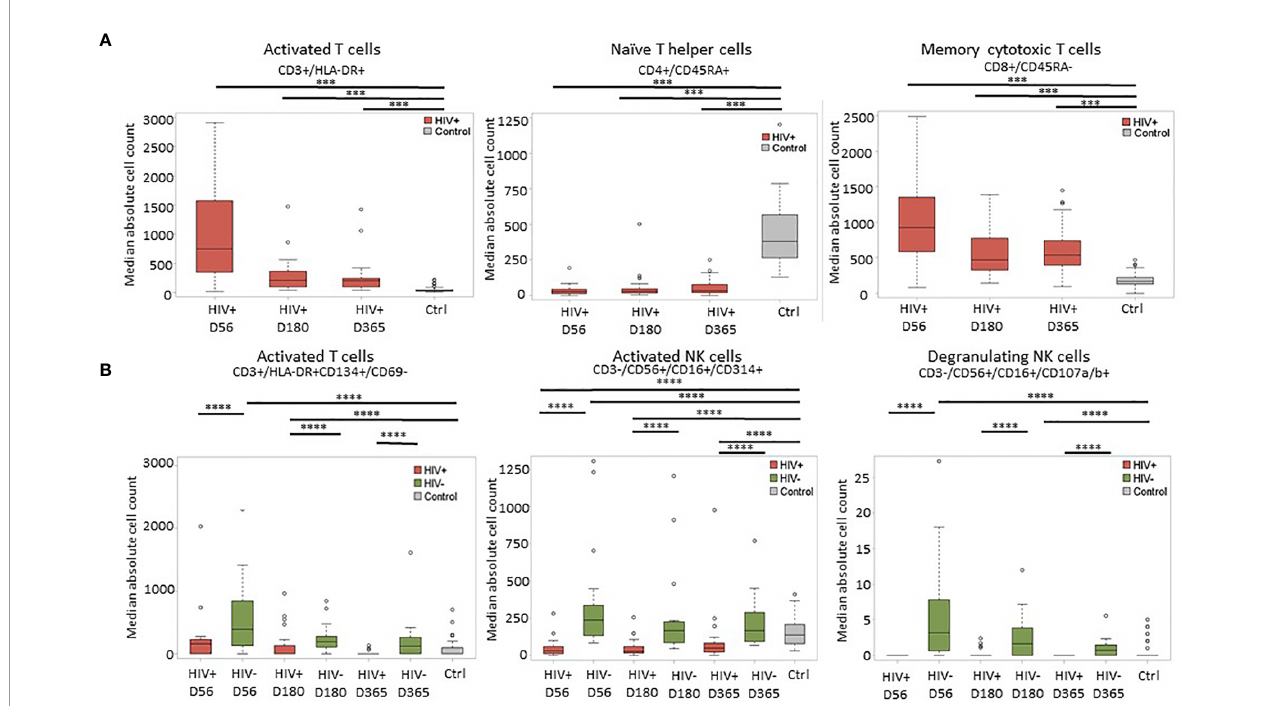
FIGURE 2 | Representative plots of median absolute cell numbers determined to be signi fi cant by the Wilcoxon-rank sum test. (A) Comparison between HIV(+) AHCT recipients and healthy controls at days 56, 180 and 365 post-transplant; horizontal lines with *** indicate comparisons with p < 0.0007. (B) Comparison of HIV (+) and HIV(-) immune features to healthy controls at days 56, 180 and 365 post-transplant; horizontal lines with **** indicate comparisons with p < 0.002.